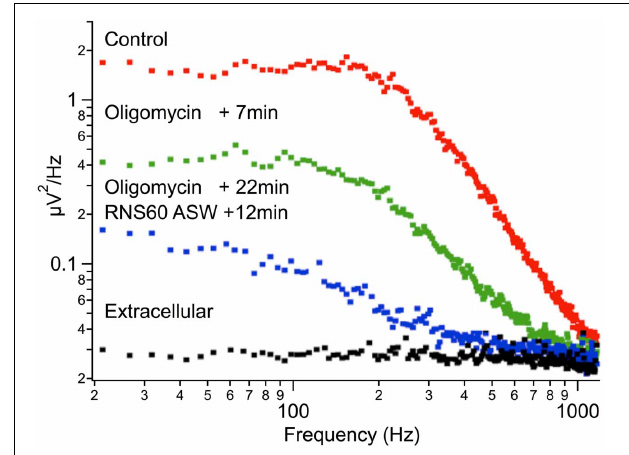
FIGURE 6 | Reduction of spontaneous synaptic release following oligomycin administration. Plot of noise amplitude as a function of frequency (note double log coordinates). Red, control ASW; green, 7min after addition of oligomycin; blue, 22min after oligomycin administration and 12min after changing superfusate to RNS60 ASW. Black, extracellular recording.